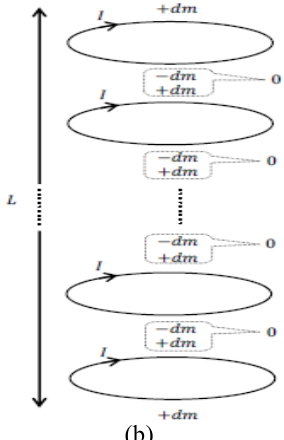
Figure 9 (b): Reduction of the currents to two layers of magnetic masses at faces 𝑎𝑏𝑐𝑑 and 𝑎 ! 𝑏 ! 𝑐 ! 𝑑 !